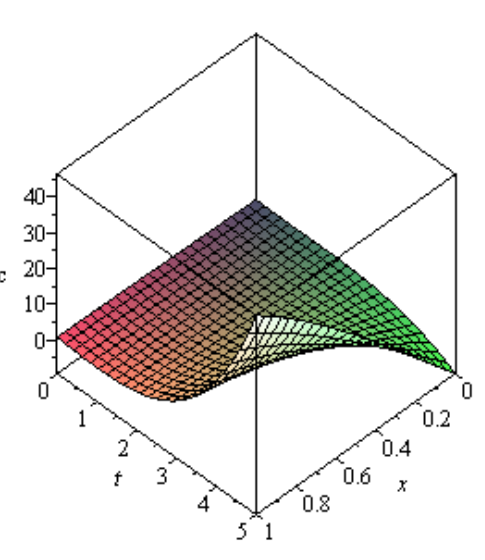
Fig. 1 represents the behavior of the fourth order ap- proximate q -FHATM surface solution of Eq. (22) verses x and time t . In Fig. 2 comparisons are made with Brownian motion i.e. α = 0.9, 0.8, 0.7 to standard motion i.e. α = 1 and show the continuity of fractional order derivatives for Eq. (22). Figs. 3(a)-(b) present the (cid:126) -curves. From Figs. 3(a)- 3b) we can see that the value of (cid:126) is selected corresponding to n from the convergence region according to the (cid:126) -curve. The (cid:126) -curves contain a horizontal line segment that indi- cates the bounded range of (cid:126) which gives the guarantee of the convergence for Eq. (30).